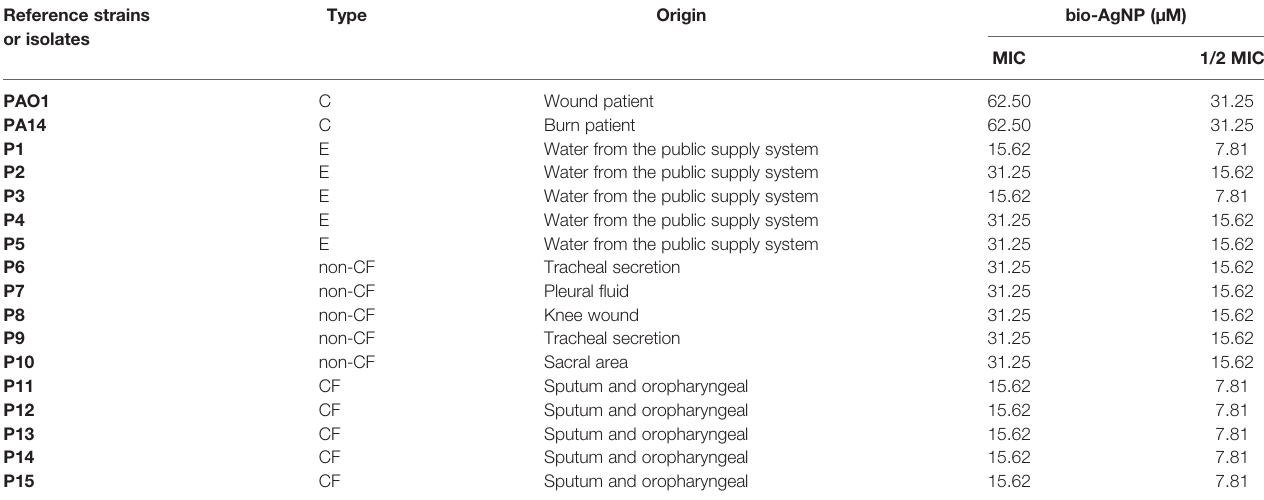
C, clinical isolates. E, environmental isolates. Non-CF, clinical isolates obtained from non-cystic fi brosis patients. CF, clinical isolates obtained from cystic fi brosis patients. MIC, Minimum inhibitory